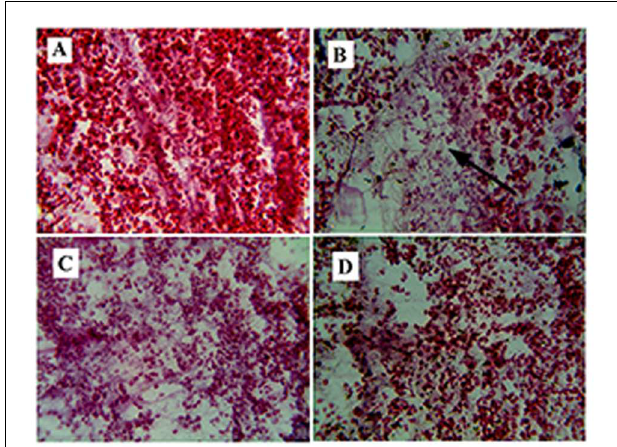
FIGURE 3 | Fibrosis in pancreas. (B) Represents Hematoxylene Eosine staining of streptozotocin (STZ) induced pancreatic section, showing fibrosis in the β -cells of pancreas (represented by arrow). (A) Represents normal pancreas with acinar cells. (C) It is the root extract (RE (100 mg/kg) treated pancreatic section, showing improvement in pancreatic structure and (D) represents glibenclamide (10 mg/kg) treated pancreatic section showing reversal of the normal pancreatic structure.